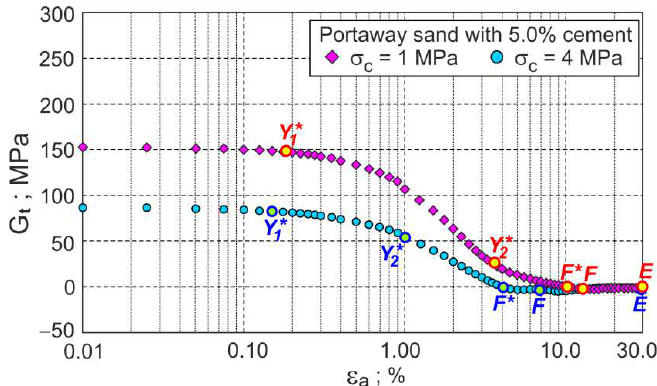
Figure 2. The stress ratio–plastic dilatancy relationship for the drained triaxial compression of Portaway sand with 5% cement.